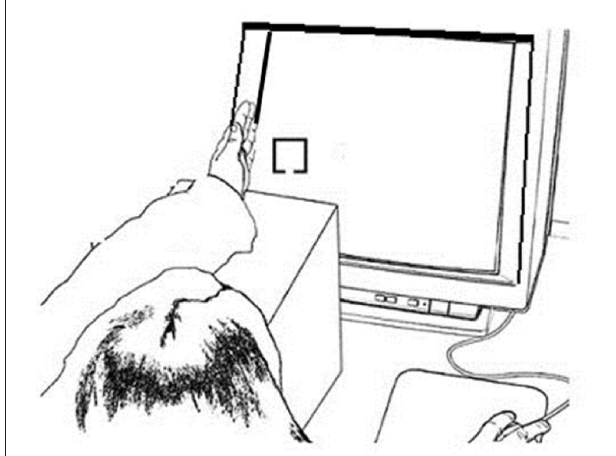
FIGURE 1 | Example experimental setup for the Hand Near stimulus Left condition. The left hand was held on the edge of the monitor screen edge and the left fixation and stimulus appears on the left side of the screen close to the hand; the right hand responded to the target.